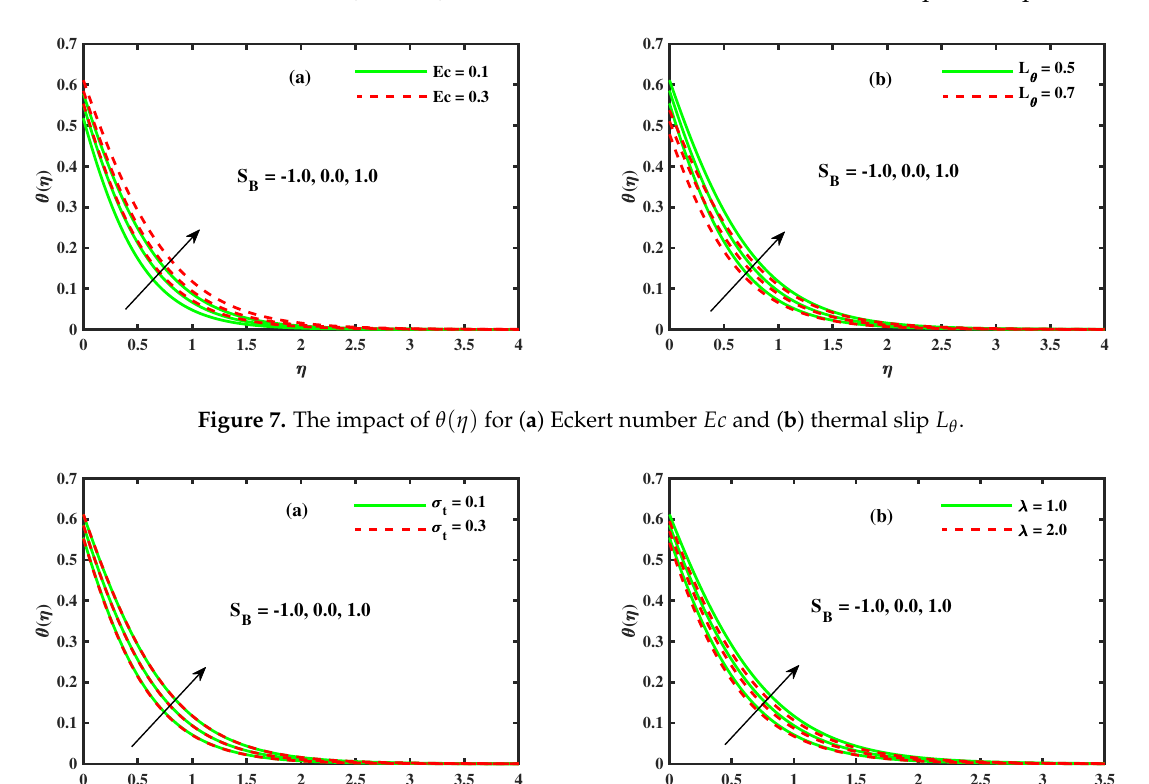
buoyancy parameter λ on θ ( η ) is presented in Figure 8b. The temperature of the nanofluid along the extending sheet is generous at the force convection stream location ( λ = 1.0 ) , which results in different values of Stefan blowing. For the heated extending surface location ( λ > 1.0), the convection current diminishes the temperature profile.